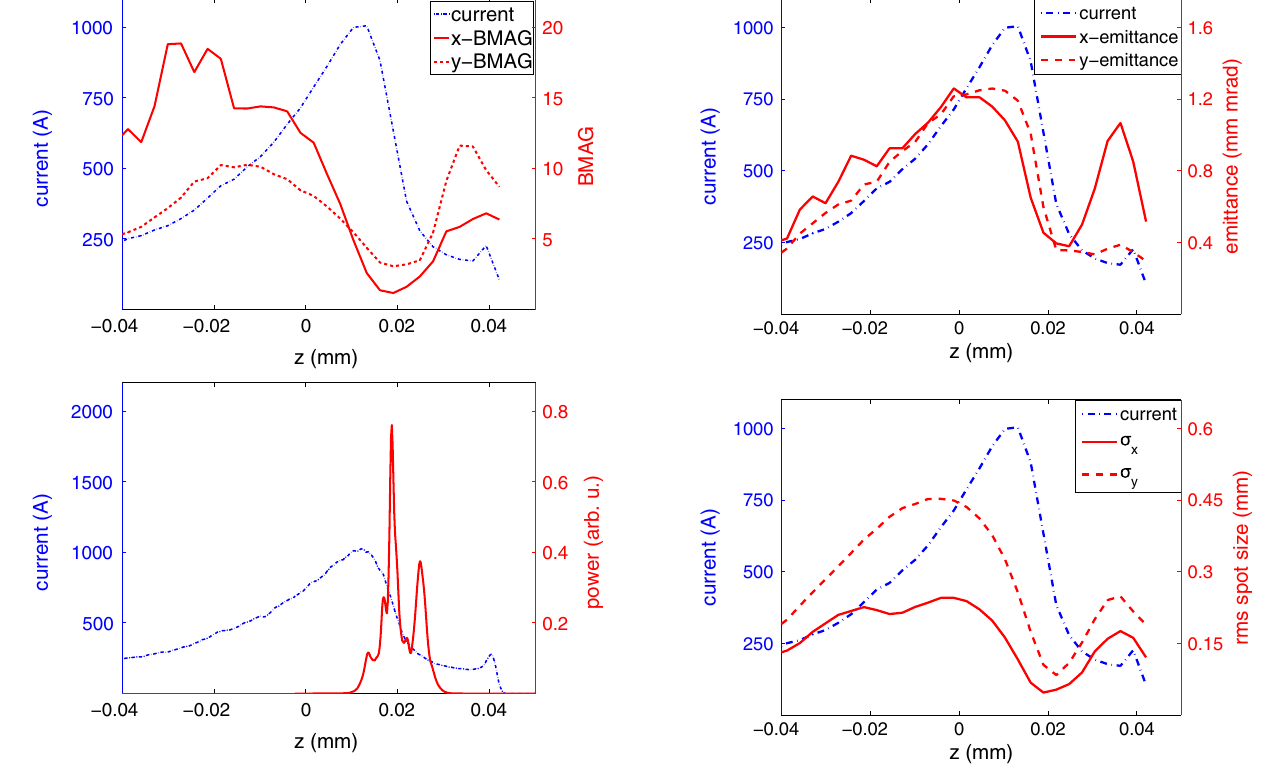
FIG. 14. Normalized slice emittance (top) and rms slice spot size at the beginning of the undulator section (bottom), resulting from start-to-end simulation for 13.5 nm.